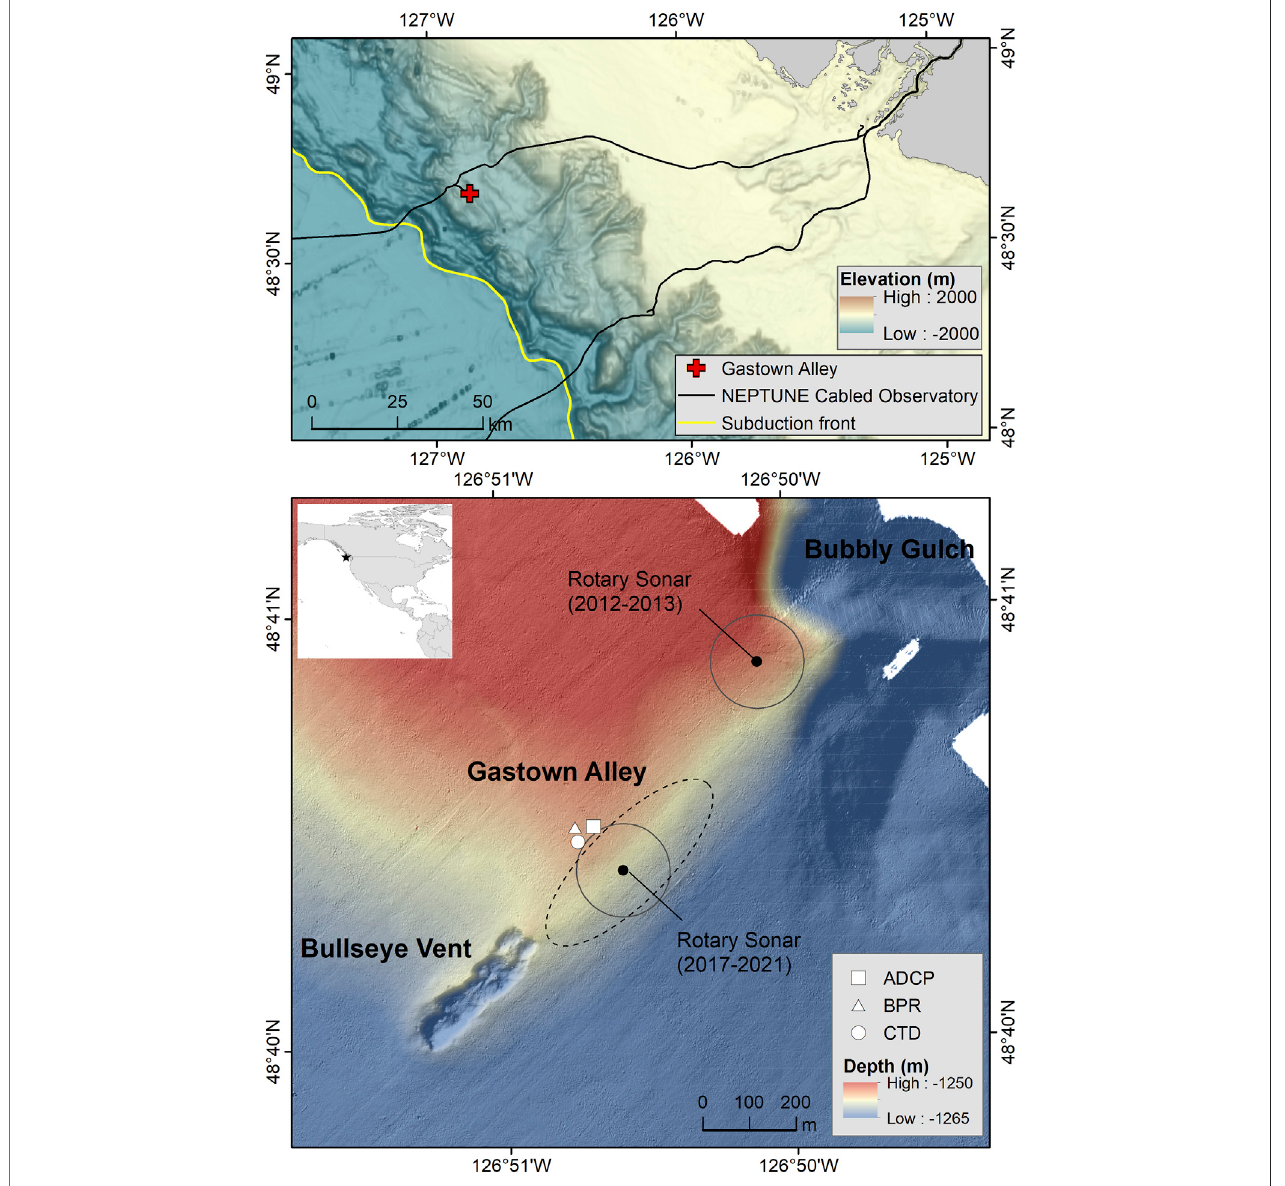
FIGURE 1| Top: location map showing Gastown Alley in relation toVancouver Island and the subduction front. Bathymetry data from GEBCO Compilation Group (2021).Bottom:overviewmapshowingthelocationofthecabledinstrumentsusedinthisworkandthemainseepareasinthevicinityofGastownAlley.Therotarysonar used by Römer et al. (2016) for the 2012-2013 monitoring is also shown. The grey circles have a radius of 100 m and delineate the monitoring areas of the sonars. Bathymetry data from AUV D. Allan B. (MBARI).